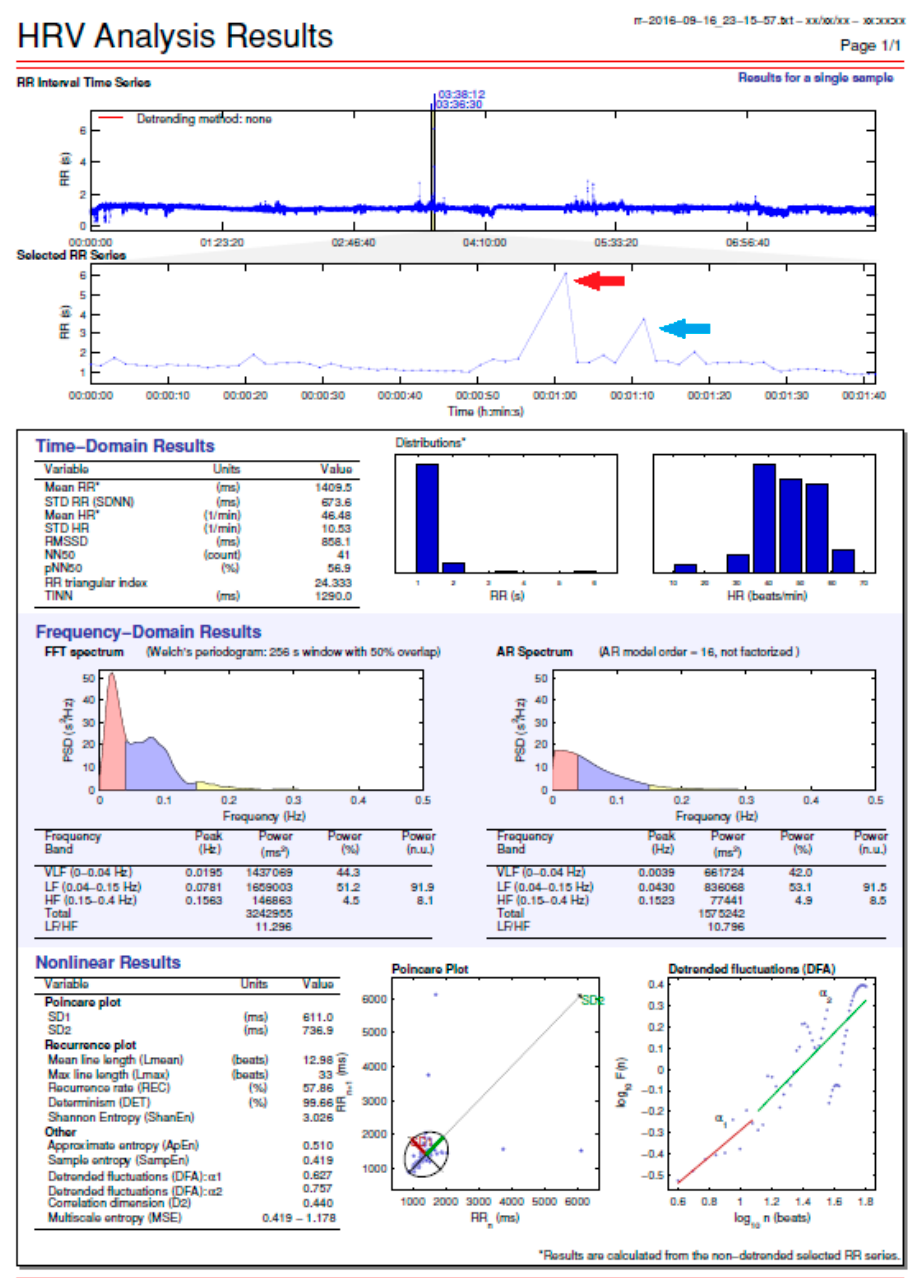
Figure 6. The HRV analysis capabilities of the Polar 800V HRM. The red arrow shows a pause of 6.118 s and the blue arrow shows a pause of 3.749 s between the R-R waves marked in the same color in Figure 1. The abbreviations in the figure are be defined because they are irrelevant to the purposes of this article.